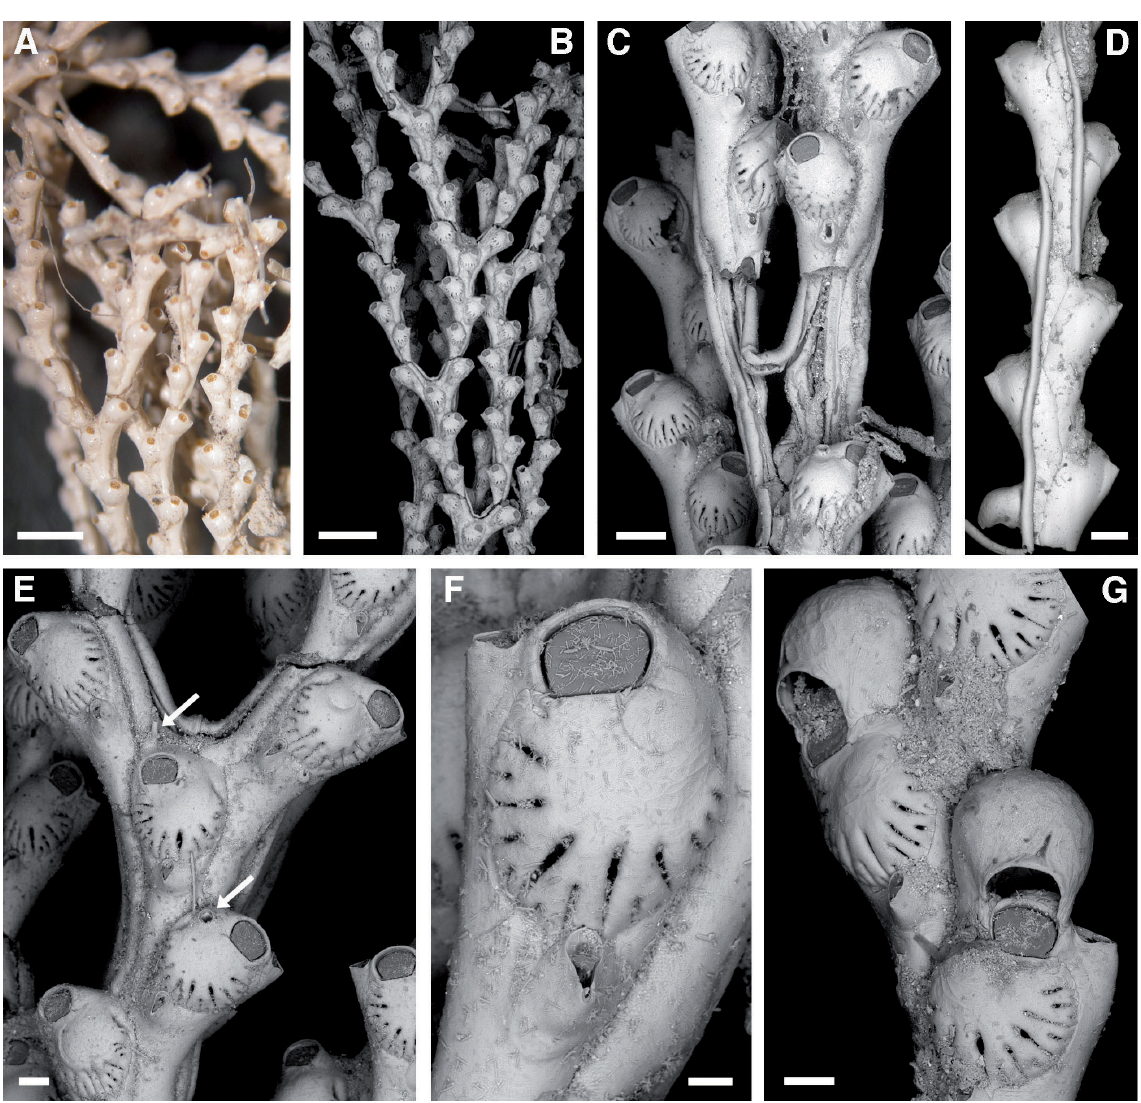
Fig. 1. Notoplites saojorgensis sp. nov. (MnHn 4163, holotype). A . Optical image of colony showing the porcelain white zooecia. B . Overview of colony showing several internodes and branch bifurcations. C . Proximal part of the colony with numerous, closely joined rhizoids emanating from proximal and abfrontal zooids, forming supporting stalks. D . Abfrontal side of internode with two rhizoids. E . Autozooids at branch bifurcation; note the basal part of the greatly enlarged spine at the base of the scutum (lower arrow) and the single spine of normal size in the median zooid at the bifurcation point (upper arrow). F . Close-up of autozooid with distolateral and proximal avicularium. G . Ovicellate zooids; note the proximomedian, acutely triangular window in the ooecium. Scale bars: A, B = 1 mm; C, D = 200 µm; e, g = 100 µm; F = 50